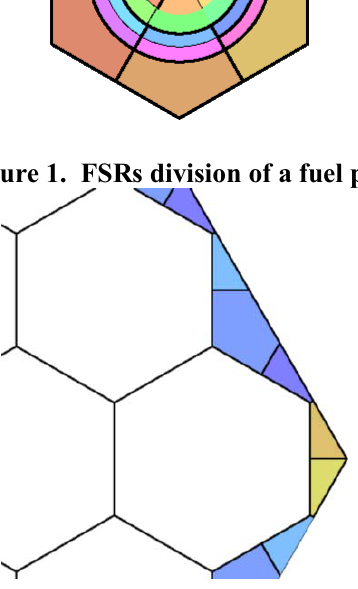
Figure 2. FSRs division near fuel